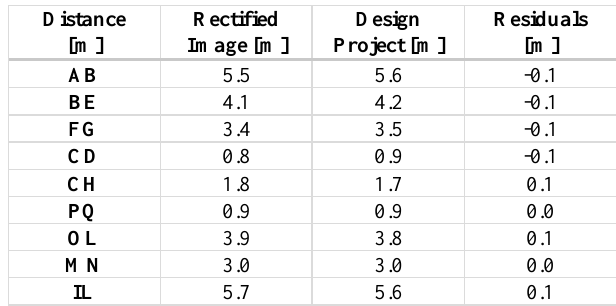
Table 2. Residuals values of distance measured on the project drawing and the rectified